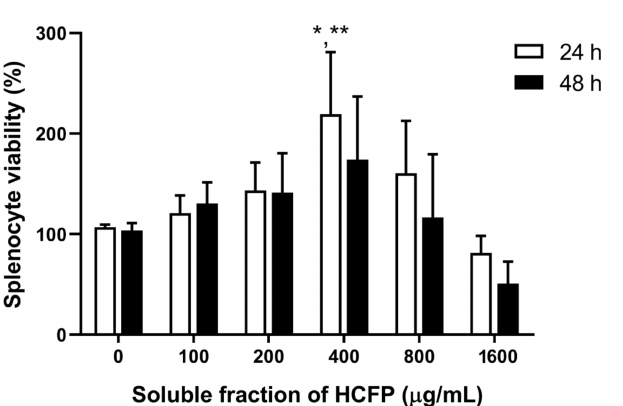
Figure 2. Effect of soluble fraction of HCFP on rat splenocyte proliferation at exposure times of 24 and 48 h. Splenocyte viability (%) was expressed as mean ± SEM from three independent experiments performed in triplicate. * p < 0.05 and ** p < 0.01 indicate significant differences between different concentrations and control (0 µ g/mL). Statistical significance was determined using one-way ANOVA followed by Dunnett’s multiple comparison test.